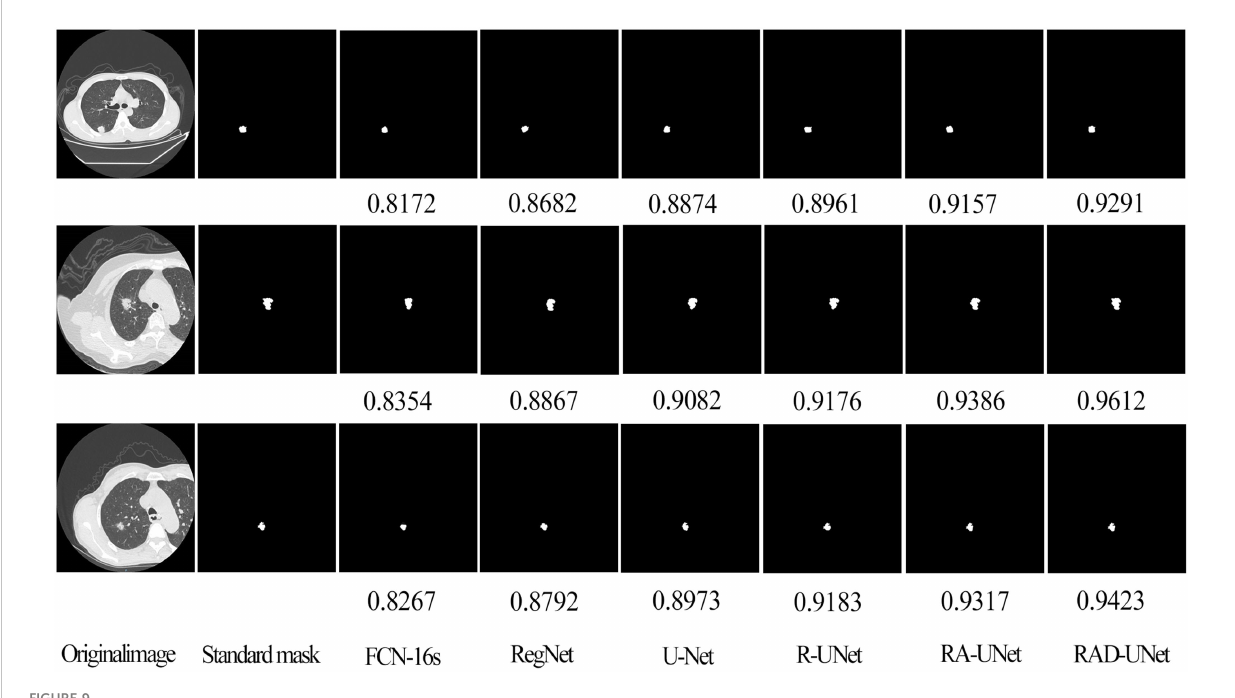
FIGURE 9 Comparison of lung nodule segmentation results on the AHAMU-LC